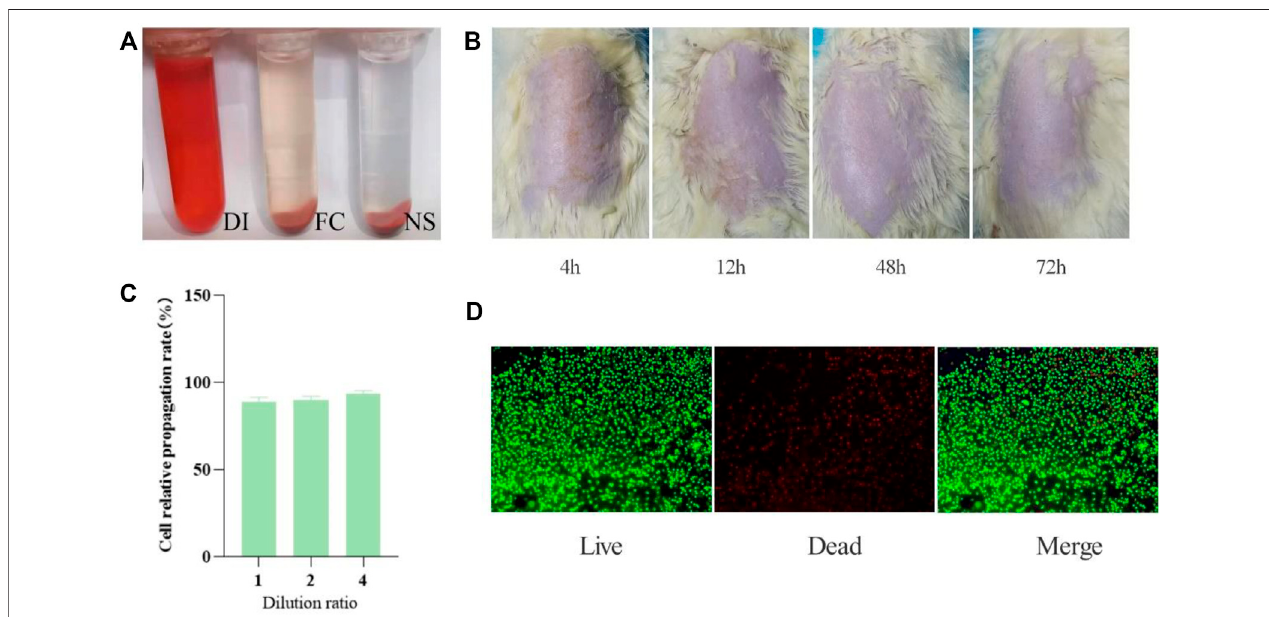
FIGURE 3 | Collagen safety test results. (A) Hemolysis test results ( n = 5 per group). (B) Skin irritation results ( n = 5). (C) Cell relative propagation rate ( n = 3). (D) Live-Dead staining of L929 cells seeded on the surface of different composites after culturing for 7 days. Live cells emit green fl uorescence, while dead cells emit red fl uorescence. Scale bar: 100 μ m n = 3.